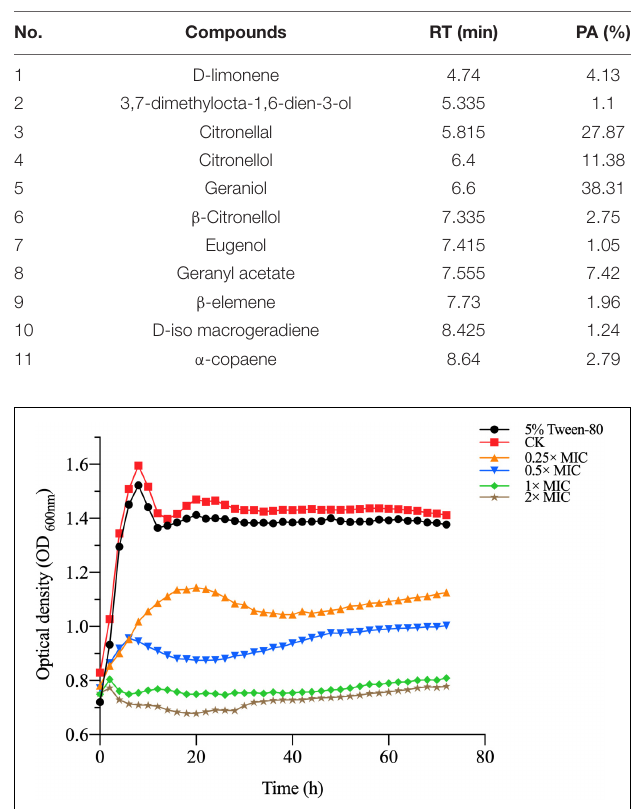
TABLE 2 | The formulation of MOEO.